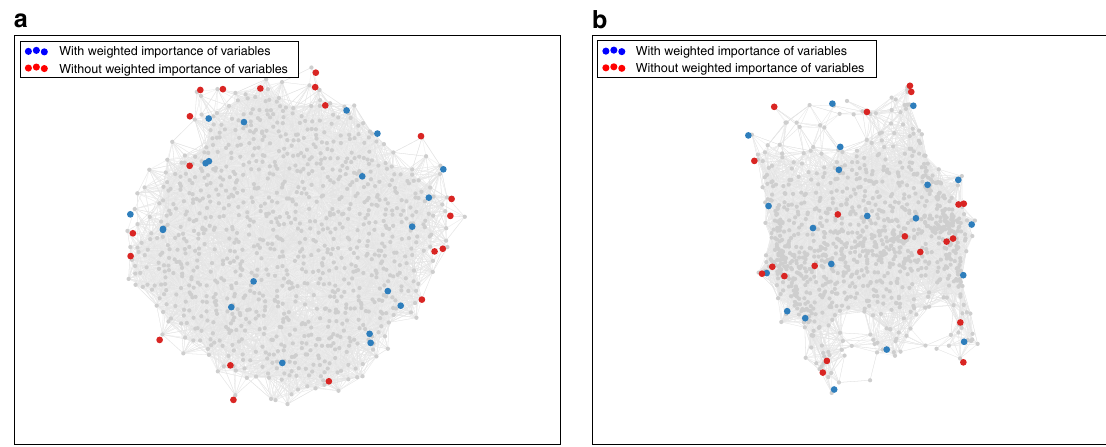
Fig. 4 Distribution of diverse sets in the chemical space of Zn-HKUST-1. Multidimensional scaling projection of the set of 20 most diverse synthesis conditions with (blue) and without (red) taking the relative impact of synthesis variables into account. Both sets are shown in the unweighted space ( a ) and in the weighted space ( b ). (HKUST = Hong Kong University of Science and Technology)